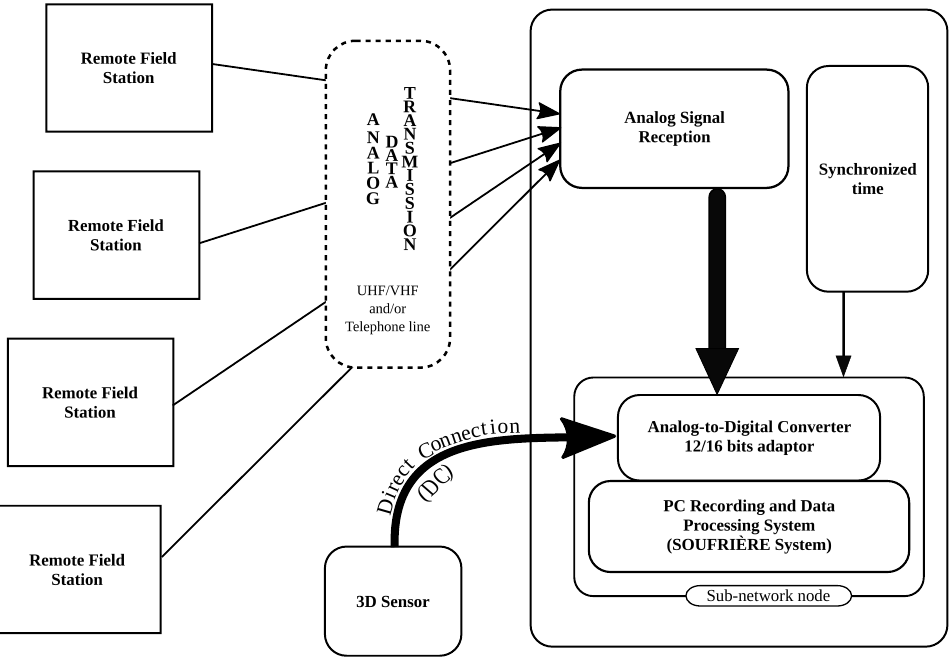
Figure 4. The 1982 Class 3 hybrid network: analogue station with analogue transmission associated with digital recording and data processing. (Figure adapted after Lynch pers.